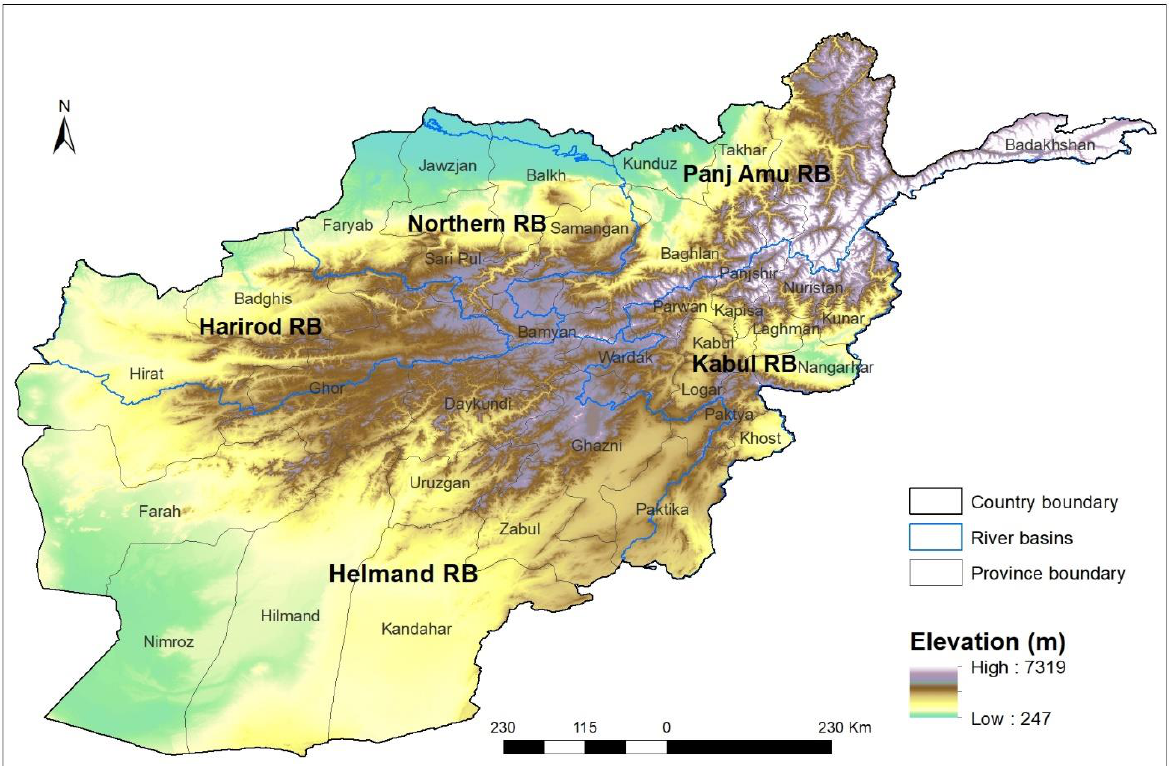
Figure 2. The location of Afghanistan, its provinces, river basins and topography.